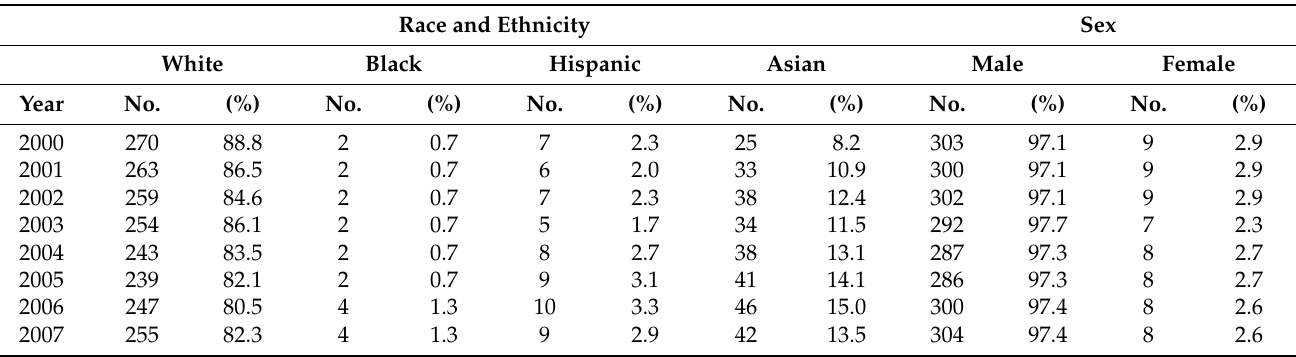
Table 1. Composition of adult heart transplantation (HTx) surgeon workforce from 2000–2020. The surgeons listed performed at least one HTx in the indicated